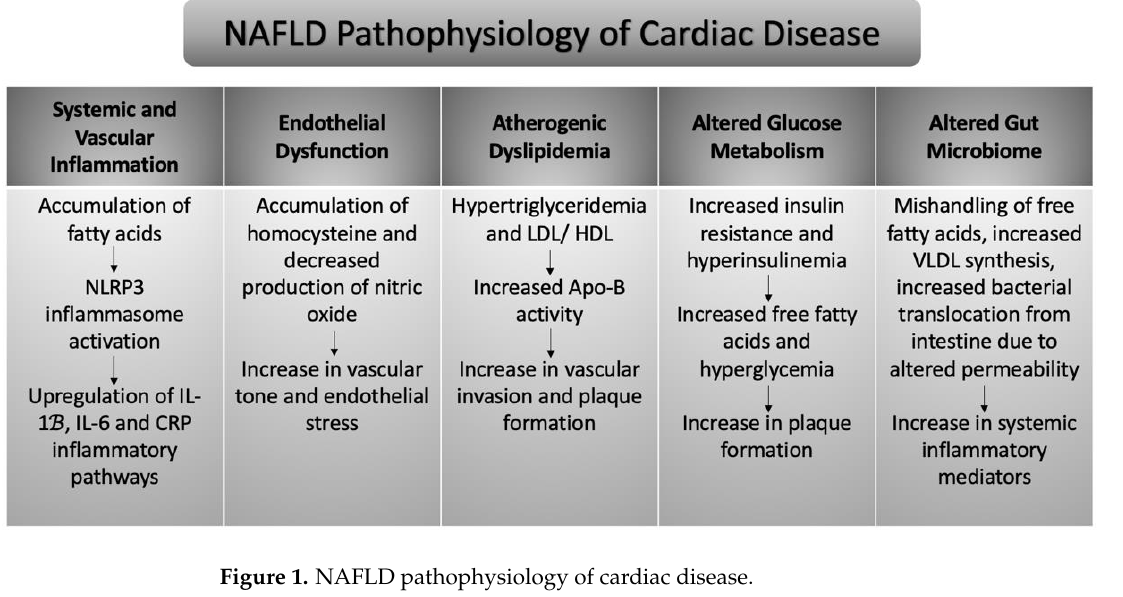
Figure 1. NAFLD pathophysiology of cardiac disease.